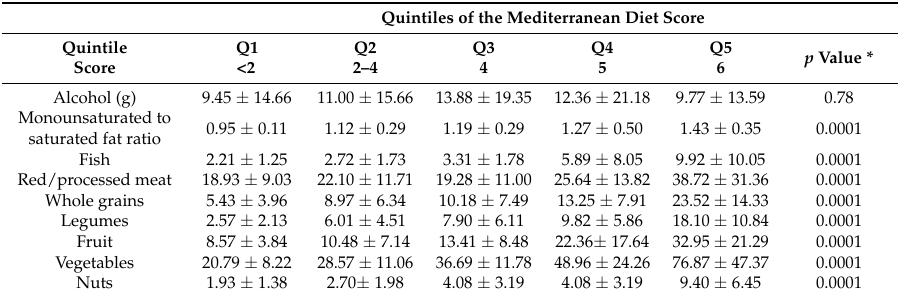
Table 2. Components of the Mediterranean diet score. All components are shown as grams per day except for the ratio of monounsaturated to saturated fats.